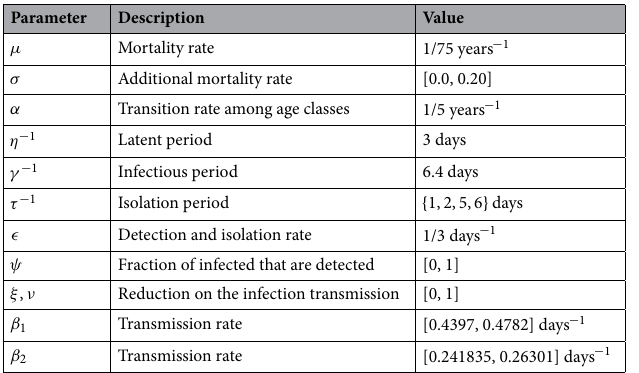
Table 2. Parameters of the model, their values (or range of values) and units 37,38 .